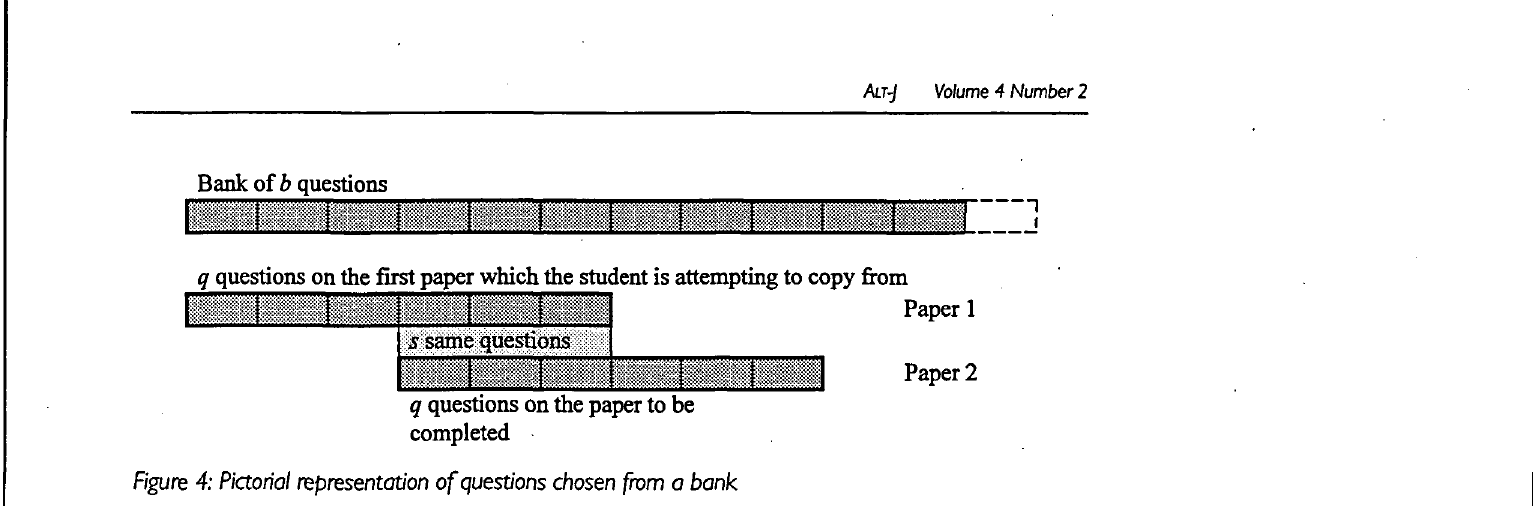
Figure 4: Pictorial representation of questions chosen from a bank of producing q questions from b is jC , the probability of doing so by chance must be 9 (j>-qCq-s • qC )fbCq- In scenario 3 this is complicated by the fact that even if a question is s duplicated, it may be a different variant to the one chosen on the original paper. Consequently, it will be assumed that of the q questions, i are the same question and s of them are the same variant of the same question.